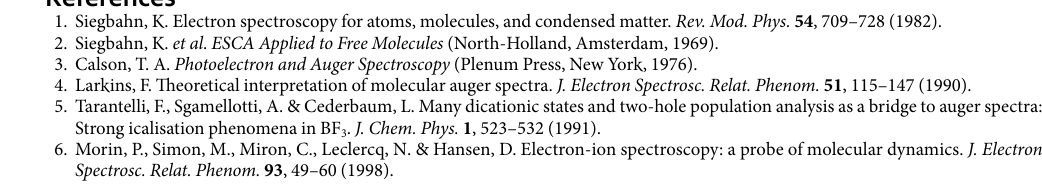
8 Scientific RepoRts | 7: 2898 | DOI:10.1038/s41598-017-02875-x